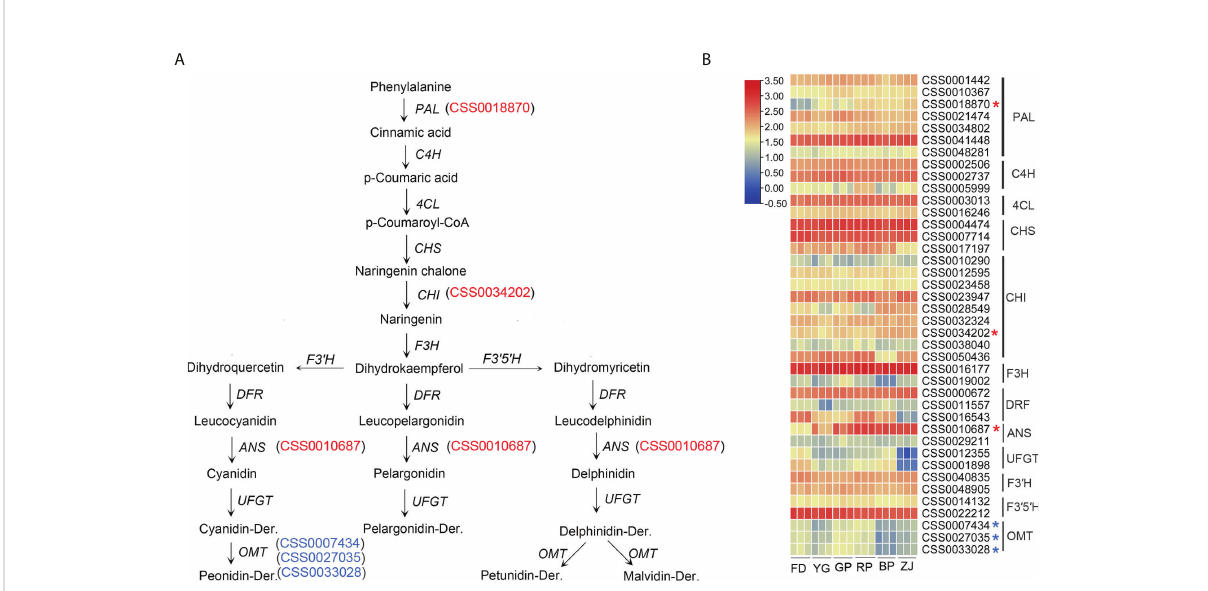
FIGURE 4 Transcript pro fi ling of genes in the anthocyanin biosynthetic pathway. (A) anthocyanin biosynthetic pathway; (B) Heat map presentation of the expression patterns of anthocyanin-related genes The up-regulated genes in purple tea plants were marked by red "*", and the OMT genes were marked by blue "*" in (B) .